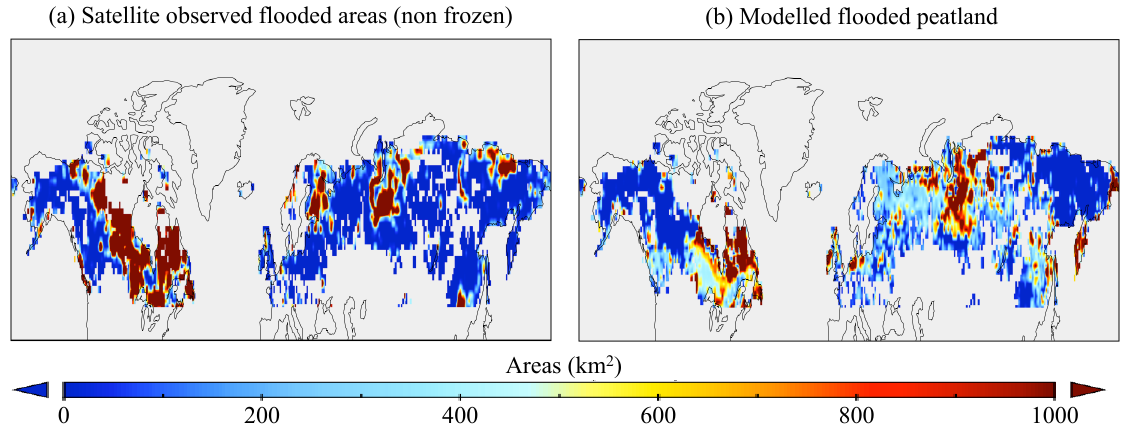
Figure 11. Extent of flooded areas (in km 2 ) for each 0.5 ◦ grid cell in the June monthly mean during the 1993–2006 period from satellite observations (a) and from simulated flooded peatlands (b) .